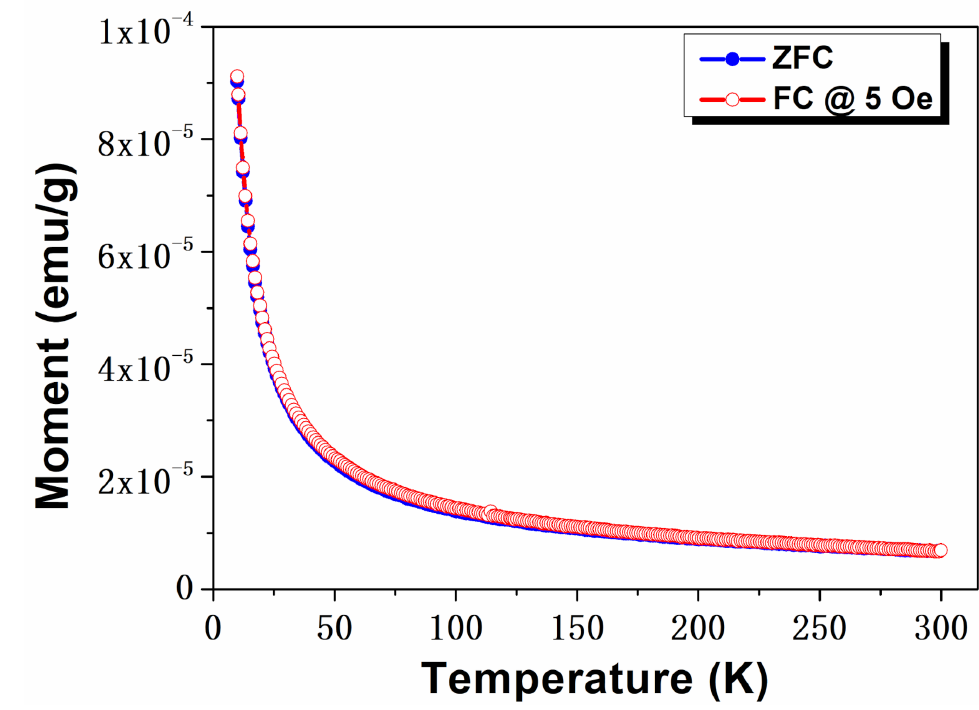
Figure 4. ZFC and FC M − T plots for CeO-2 sample at field of 500 Oe.